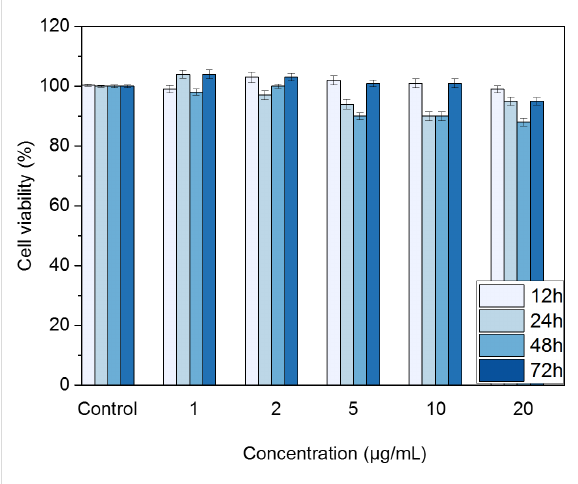
Figure 4: Raman spectra of the functionalized CNOs. The Raman spectra are normalized to the G-band at 1580 cm − 1 and the ratios of the D-band to the G-band intensities are indicated.